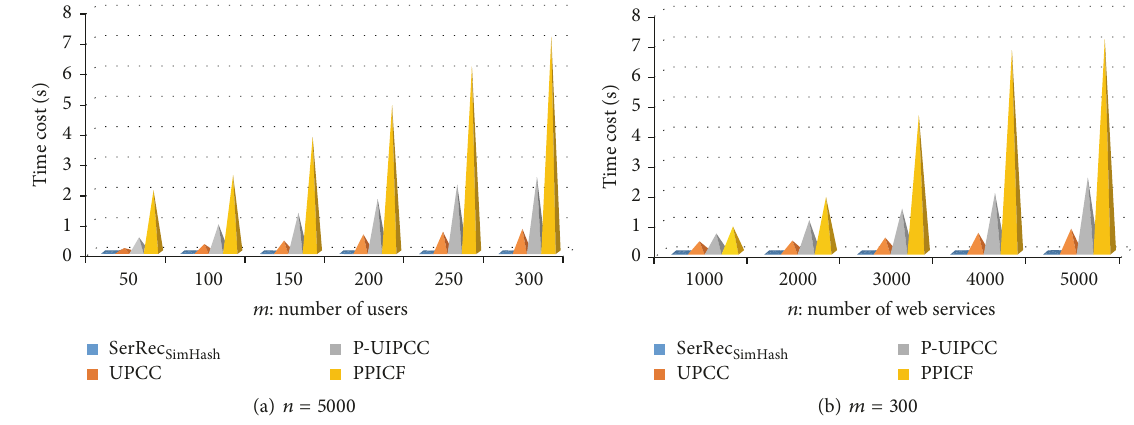
Figure 3: Recommendation efficiency comparison of four